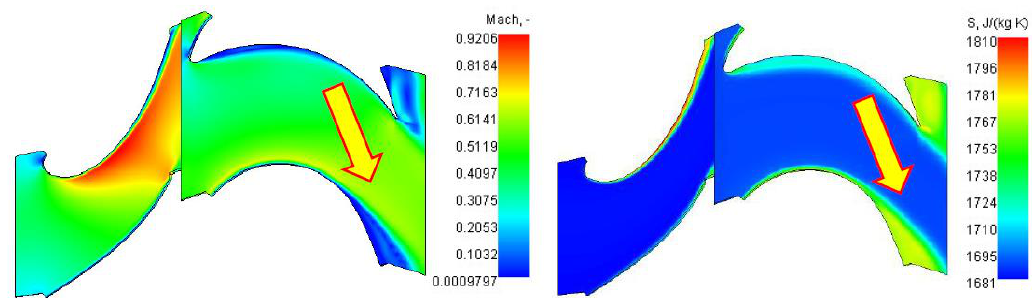
Figure 31. Pressure ( left ) and turbulent kinetic energy ( right ) contour details of the rotor blade (28% spanwise).